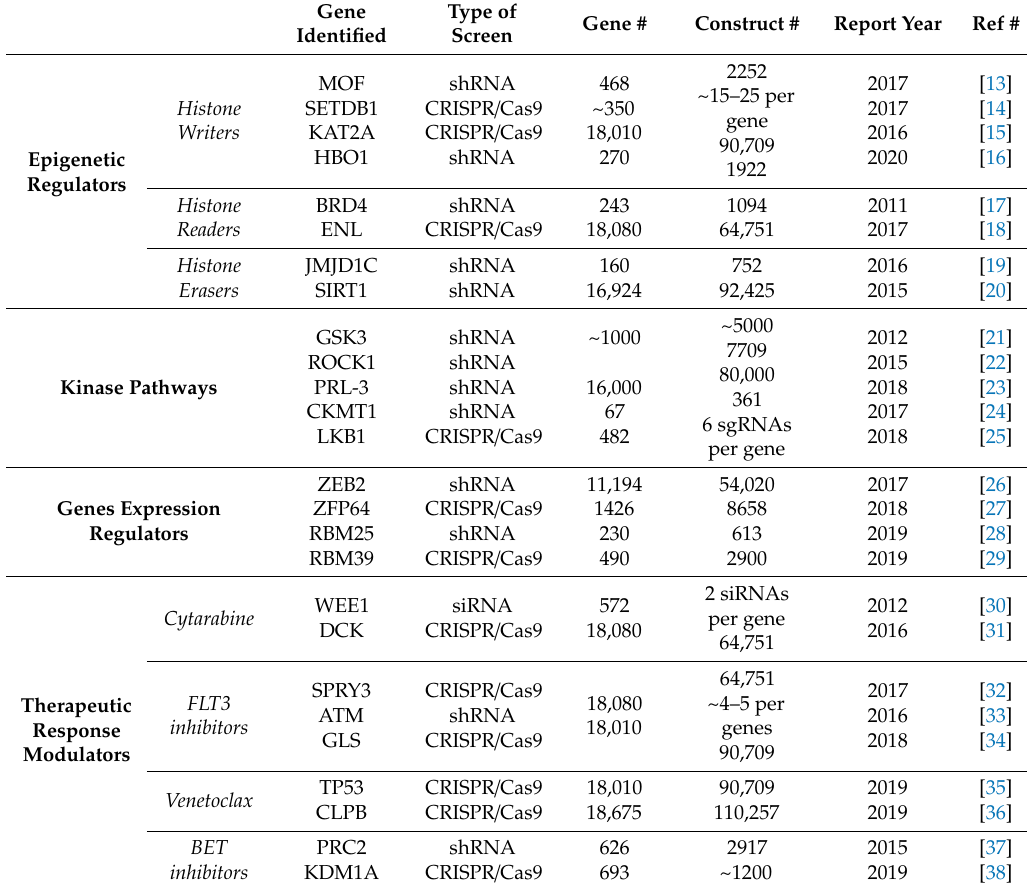
Table 1. Summary of AML-related genes identified via high-throughput genetic